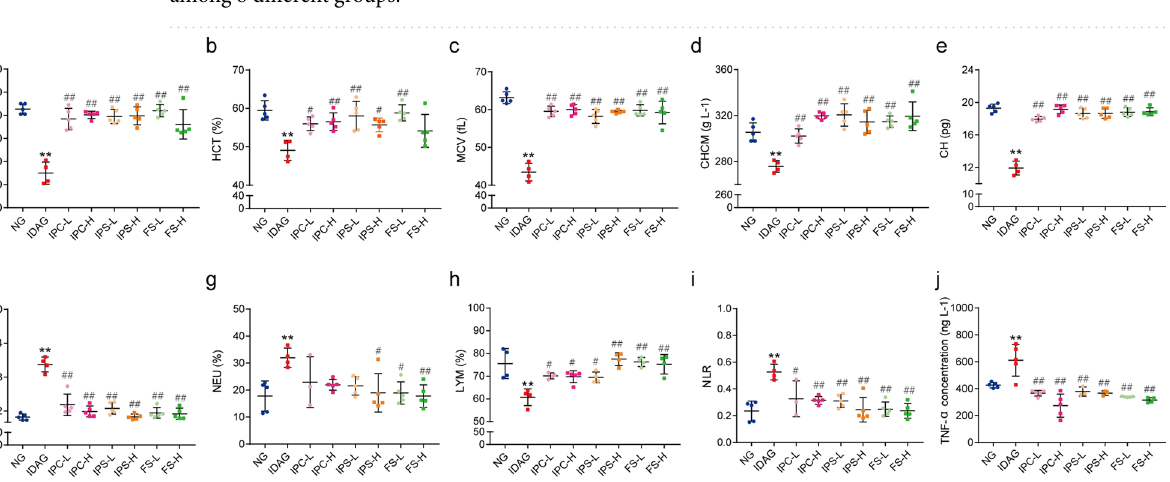
Figure 2. Haematological indexes of maternal rats after iron supplement treatment. The whole blood of maternal rats was collected and the haematological indexes were tested. ( a ) HGB. ( b ) HCT. ( c ) MCV. ( d ) CHCM. ( e ) CH. ( f ) RDW. ( g ) NEU. ( h ) LYM. ( i ) NLR. ( j ) TNF-α. HGB haemoglobin, HCT Hematocrit, MCV mean corpuscular volume, CHCM cell haemoglobin concentration mean, CH haemoglobin content of red blood cell, RDW red cell volume distribution width, NEU neutrophil, LYM lymphocyte, NLR neutrophil-to- lymphocyte ratio, TNF‑α tumor necrosis factor α. Data are presented as mean ± SD ( n = 5). * p < 0.05, ** p < 0.01, compared with NG, # p < 0.05, ## p < 0.01, compared with IDAG. One-way ANOVA followed by Tukey multiple comparison test was used for comparison among 8 different